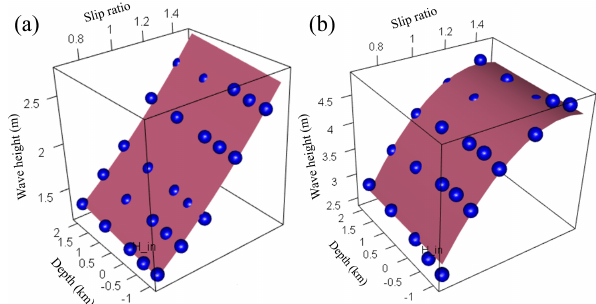
Figure 7. Response surfaces at (a) Oiso and (b) Miura for source 8 of the Sagami Trough earthquake. The blue circle denotes the maxi- mum wave height obtained from the tsunami numerical simulations, and the red curved surface denotes the response